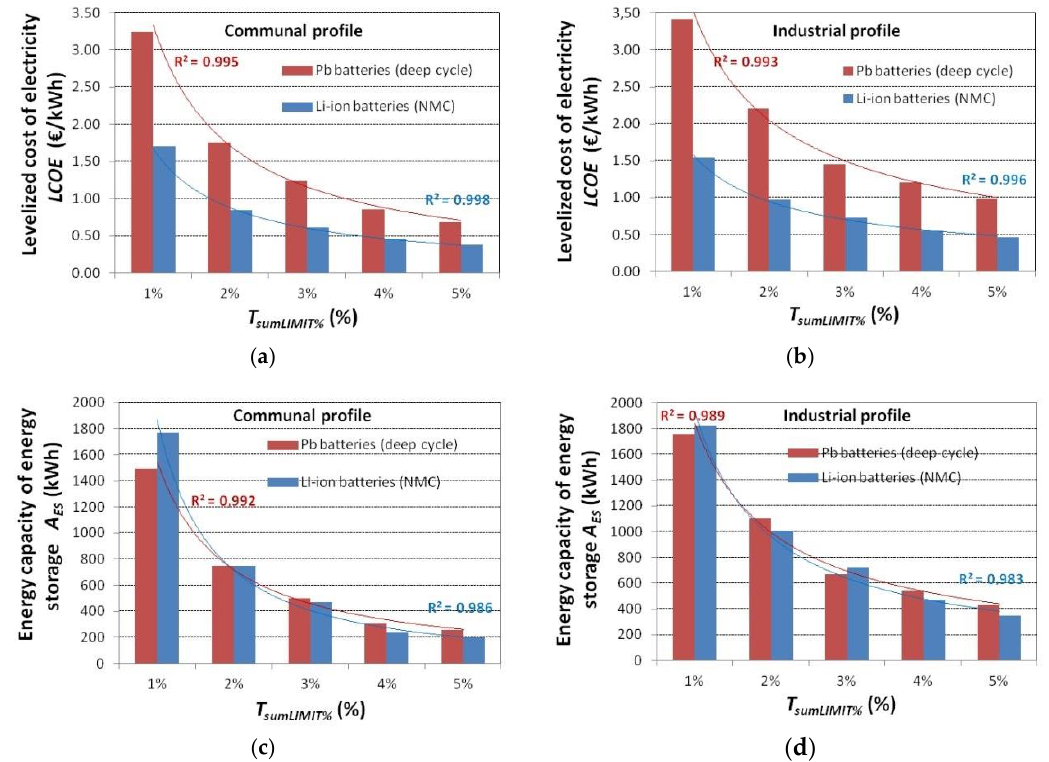
Figure 12. Changes in selected parameters of the optimized systems with power P n limited to 200 kW in the function of time T sumLIMIT% : the unit cost of generating energy ( LCOE ) consumed for supplying a communal load ( a ) and industrial load ( b ); energy capacity of a battery pack for a communal load ( c ) and industrial load ( d ).